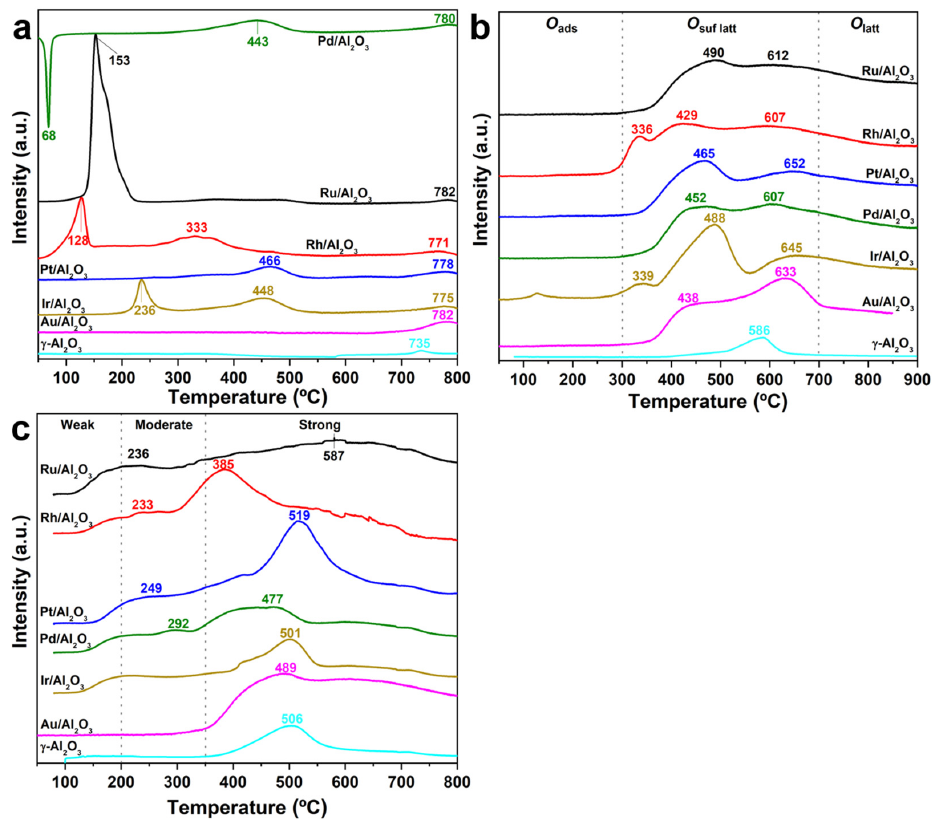
Figure 7. ( a ) H 2 -TPR, ( b ) O 2 -TPD, and ( c ) NH 3 -TPD profiles of all prepared catalysts.